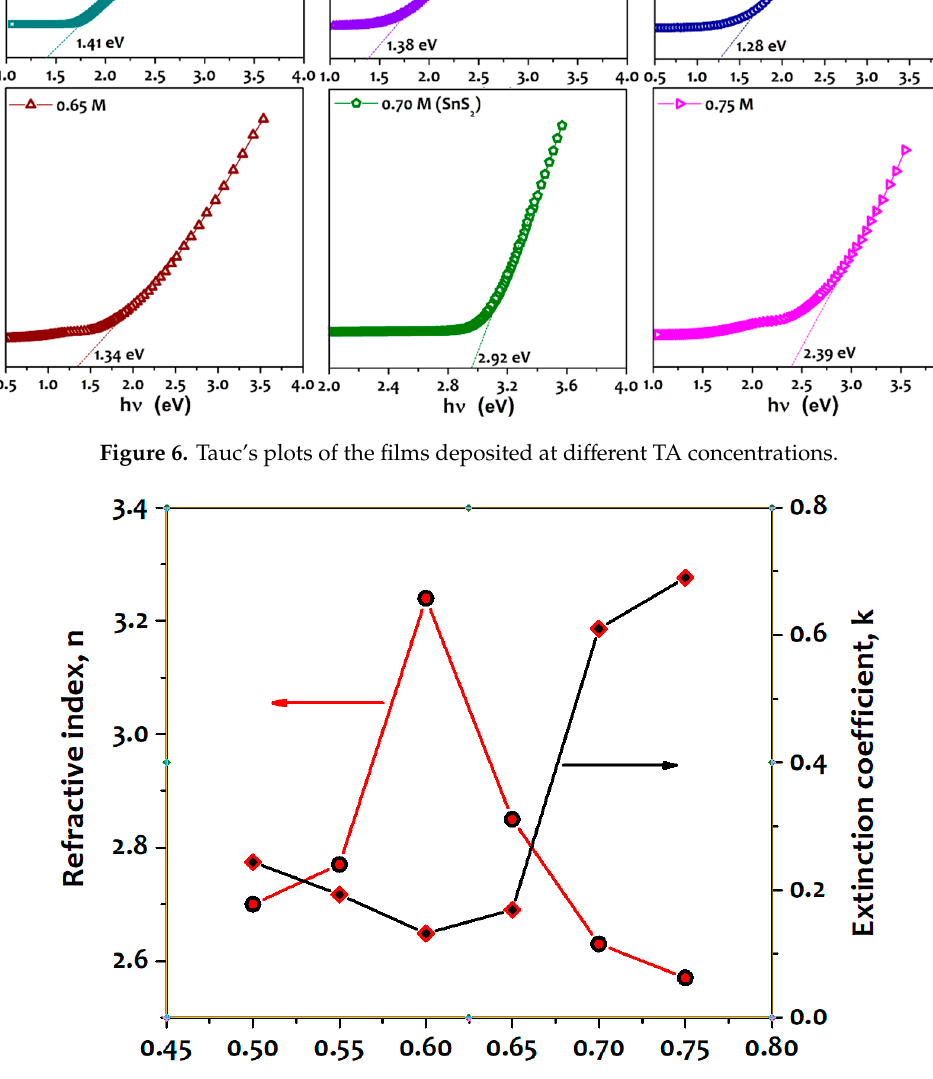
Figure 7. Variation of n and k with TA